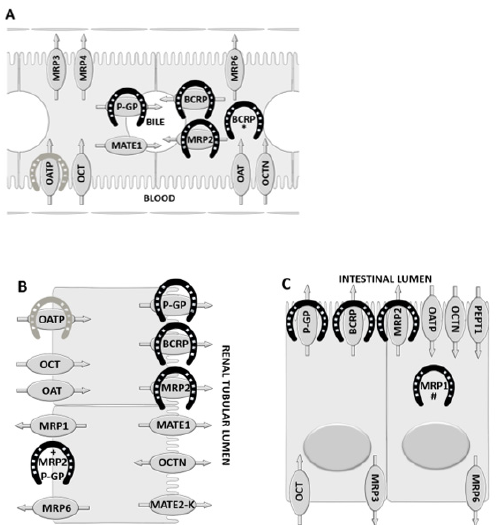
Figure 1. Schematic diagrams showing the localization of some of the major drug transporters in: ( A ) hepatocytes, ( B ) renal tubular epithelial cells, and ( C ) enterocytes. The proteins shown inside ovals